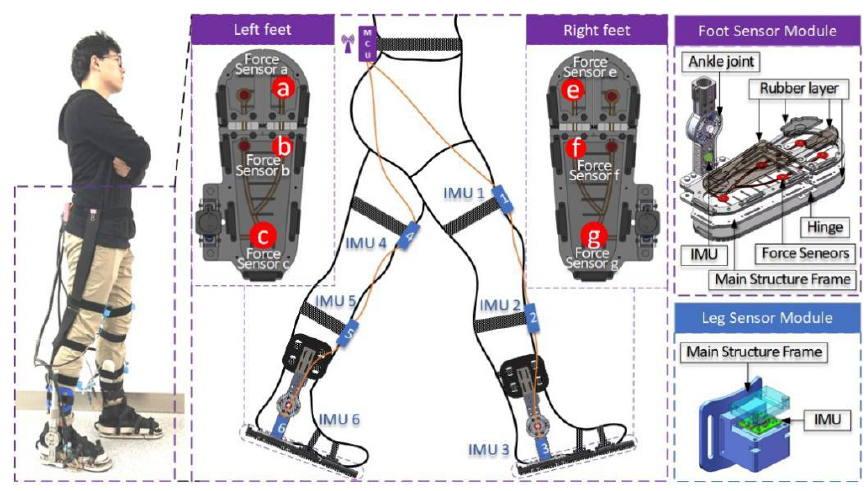
Figure 3. Design of wearable gait analysis system.